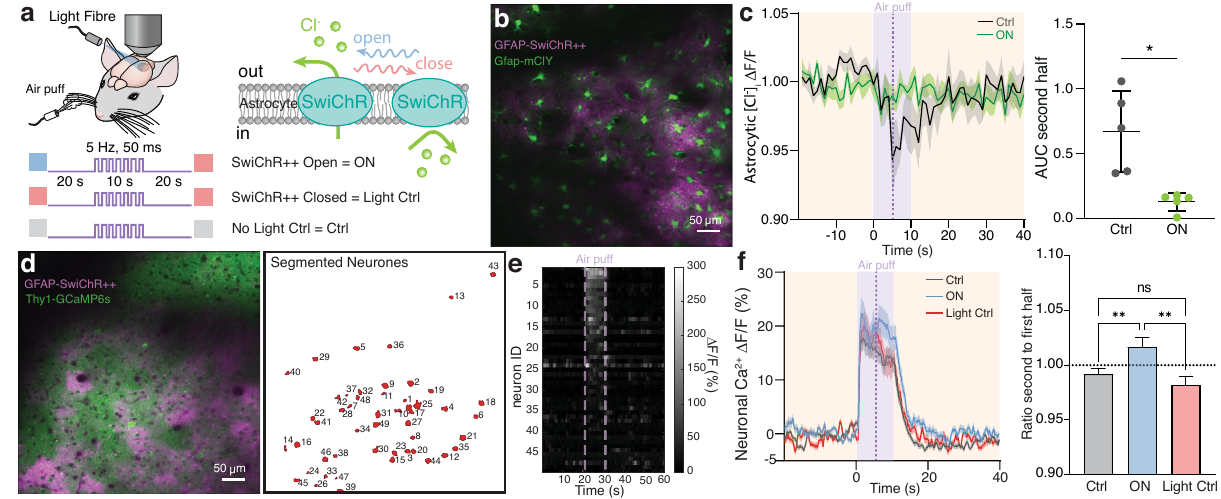
Fig. 4 | Optogenetic depletion of astrocytic [Cl − ] i extends activation-induced neuronal[Ca 2+ ] i signal. a The optogenetic switchable Cl − channel was expressed in astrocytes to manipulate [Cl − ] i , while astrocytic [Cl − ] i or neuronal [Ca 2+ ] i were imaged using mClY or GCaMP6s, respectively. As a negative control, no light or only red-lightstimulation was applied to mice expressing SwiChR++. The awake, head- fi xed micewerewhisker stimulated usingairpuffs. b Average projection of Gfap-mClY and Gfap-SwiChR++ imaged on the two-photon microscope (2PM). c Average astrocytic [Cl − ] i trace during whisker stimulation in control, light control and upon light-activation of SwiChR++ in astrocytes, shading indicates ±SD. AUC during the second half (last 5s) of whisker stimulation, error bars indicate ±SD. N =5 mice, paired two-tailed t -test, * p =0.0278. d Average